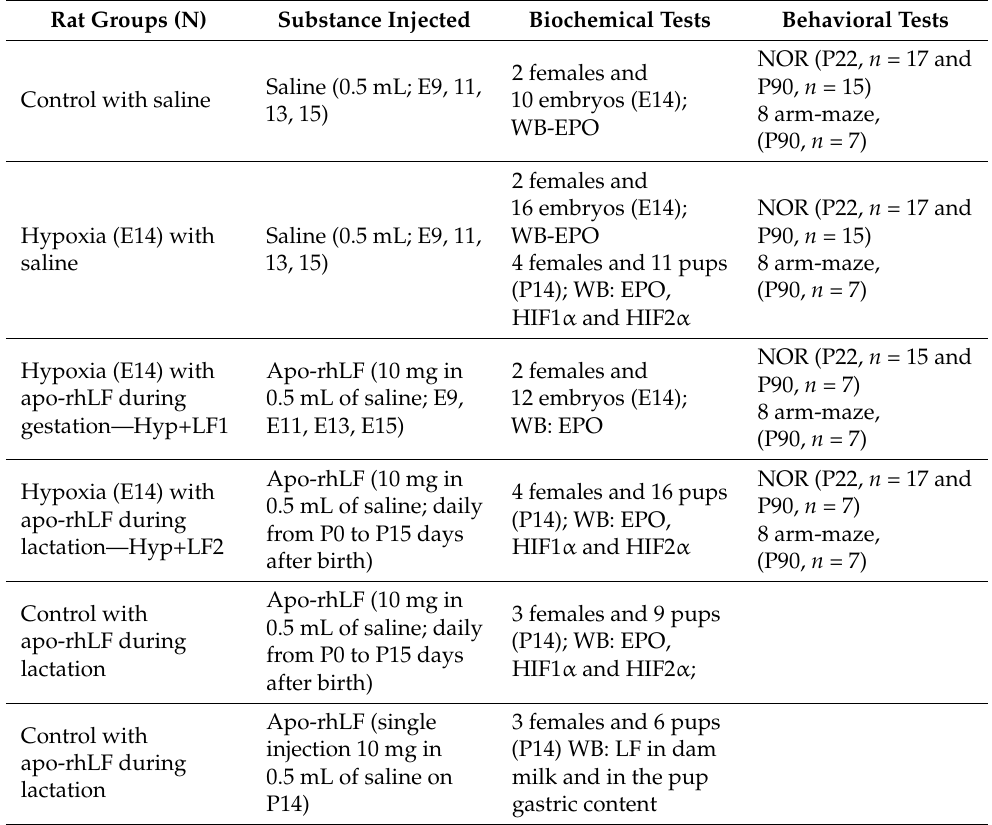
Table 1. Groups of experimental animals and the means of their